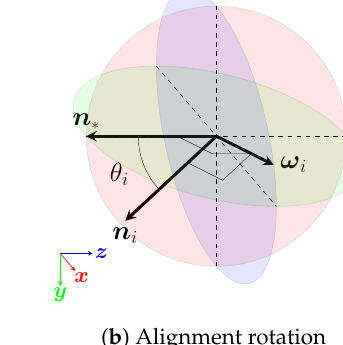
( a ) Surface and camera parameterization ( b ) Alignment rotation Figure 3. A smooth surface, , is parameterized by its mass and orientation centroids, c i L i and n i , respectively. The surface is aligned to and centered on a the virtual image plane (similarly, (cid:124) n i ) degrees around parameterized by c and n ) by performing: (1) a rotation of θ i = arccos ( n ∗ ∗ ∗ ) c i n i axis and (2) a translation of t i = c the ω i = n exp ( θ i [ ω i ] × ∗ × ∗ −